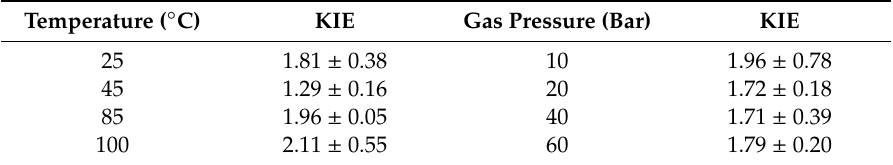
Figure 3. Average catalytic activity for NiTSNH 2 in the conversion of 6-methyl-5-hepten-2-one at different temperatures and gas (H 2 -red or D 2 -blue) pressures with a reactant flow rate of 0.5 mL/min and 60 bar. Table 1. Average KIE as a function of temperature and gaseous reductant pressure.